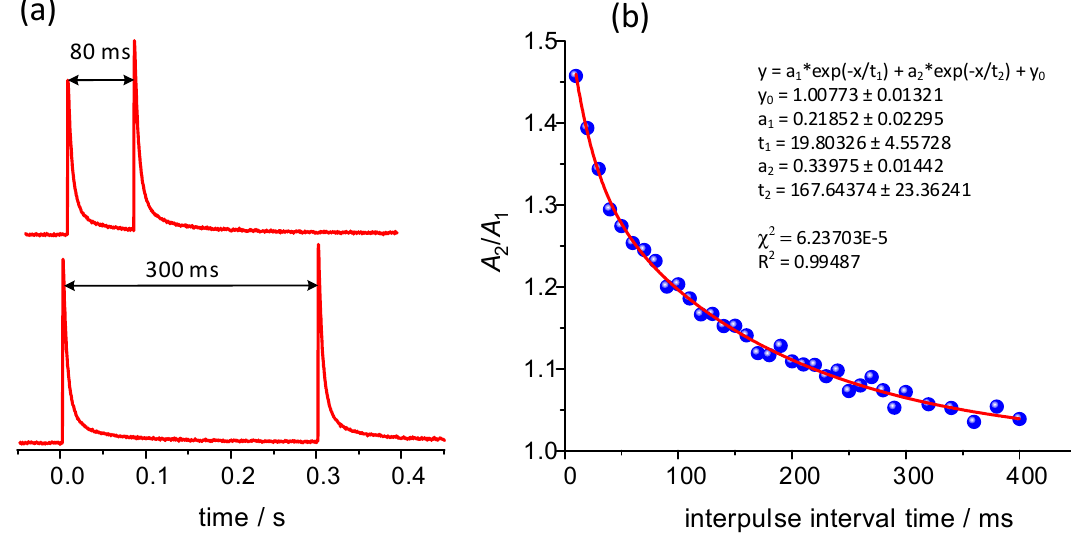
Figure 3. The photocurrent spikes resulting from the pulsed light illumination of CdS-based photoelectrodes ( a ) and the analysis of the photocurrent amplification vs. time interval between subsequent pulses ( b ).